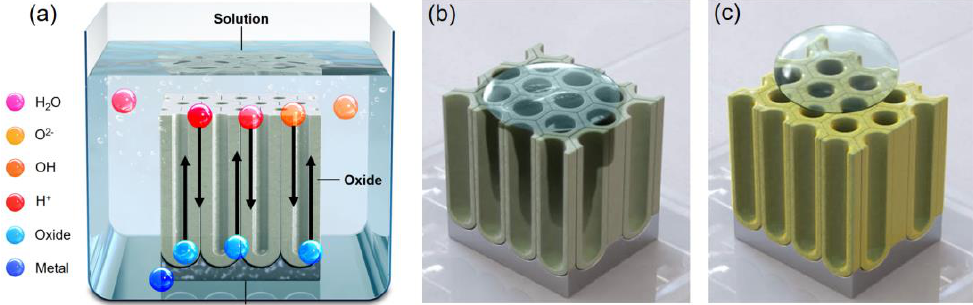
Figure 1. Schematics of ( a ) the creation of a nano-oxide structure using an anodizing method in solution, ( b ) the hydrophilic (wetted) property on a nano-oxide surface, and ( c ) the hydrophobic (dewetted) property on a nano-oxide surface.